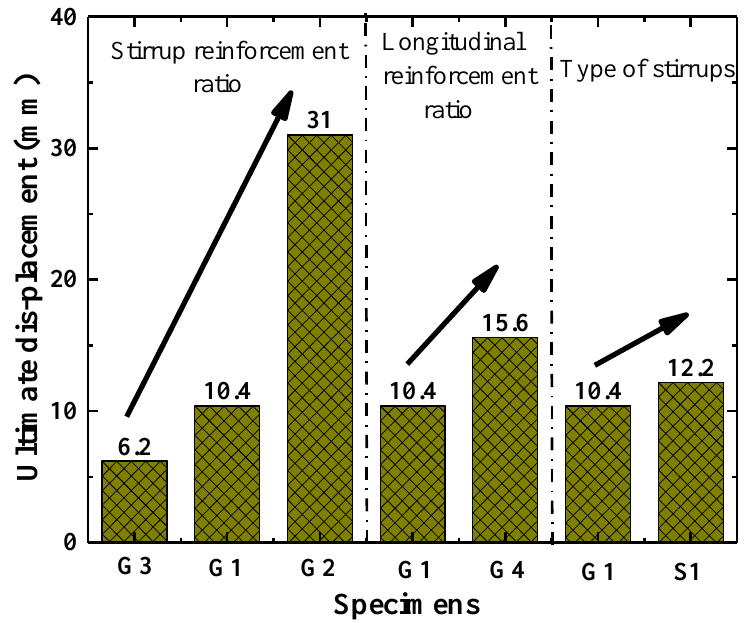
Figure 11. The effect of various parameters on shear capacity.